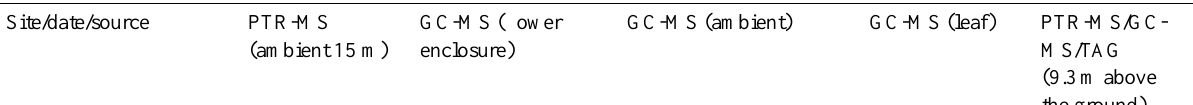
Table 1. Comparison of estragole volume mixing ratios.